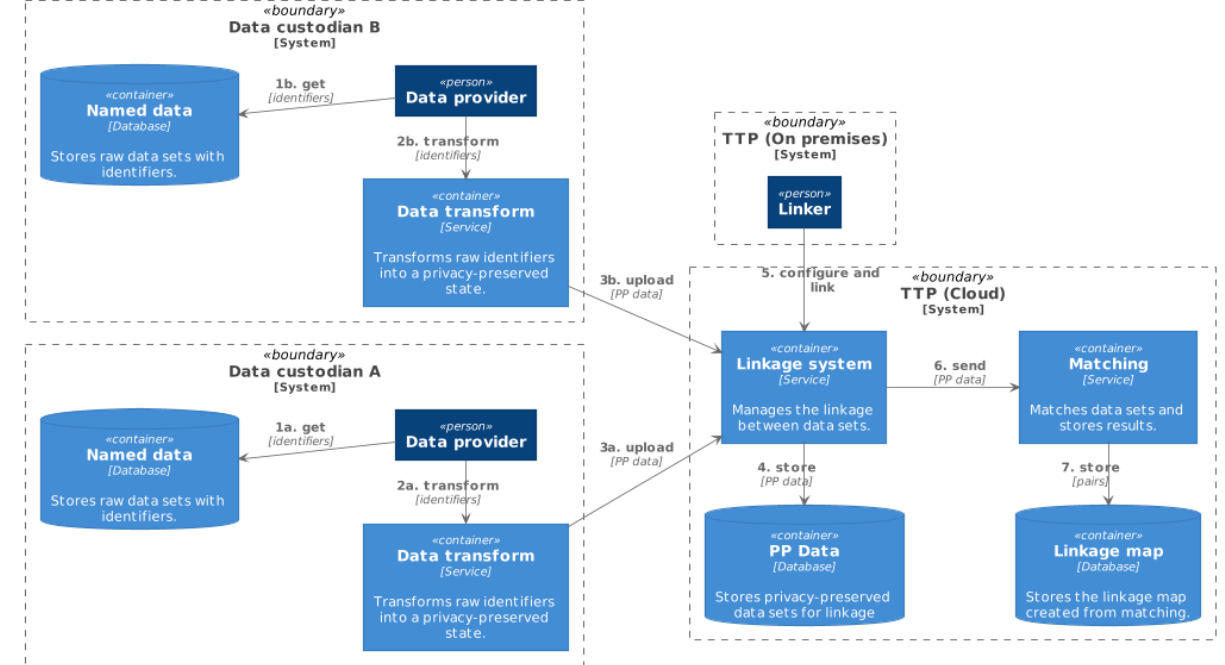
Figure 3. Full cloud trusted third party model. PP: privacy-preserved; TTP: trusted third